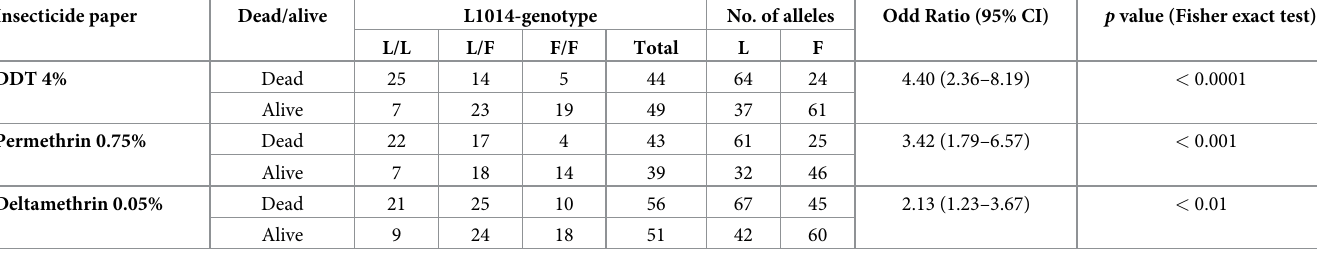
Table 5. L1014- kdr genotype and resistance phenotype relationship among An . subpictus Form